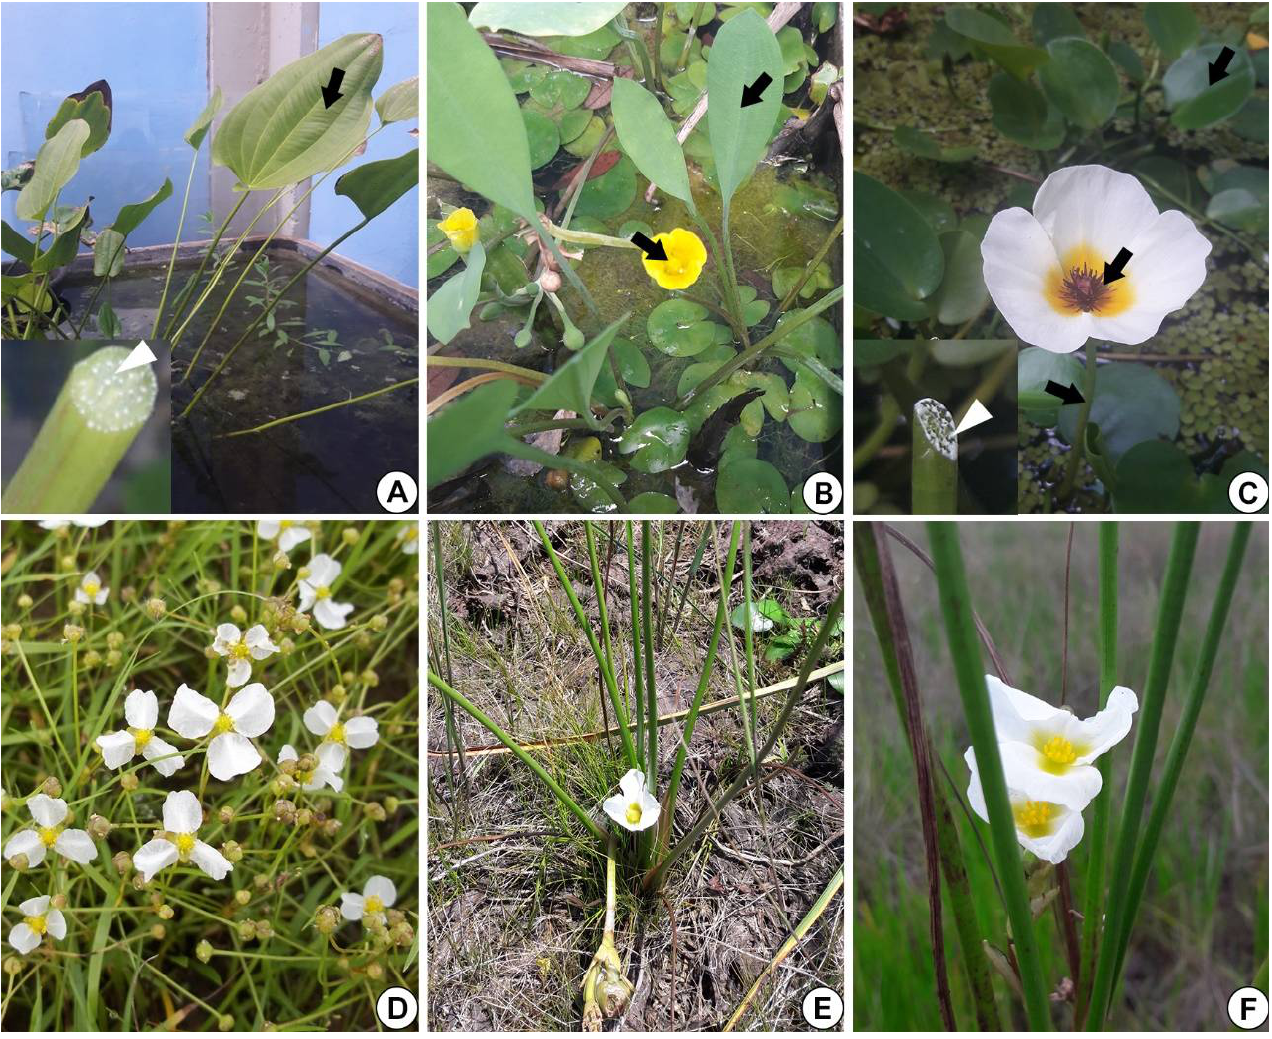
Figure 1. Alismataceae species analyzed. ( A ) Echinodorus grandiflorus leaf (arrow). Inset: detail of the petiole with white secretion (white arrowhead). ( B ) Limnocharis flava showing leaves and flowers (arrows). ( C ) Hydrocleys nymphoides : leaf, petiole and flower (arrows). Inset: note on the left side the petiole with white secretion (white arrowhead). ( D ) Helanthium tenellum (Image D: Giseli Catian). ( E , F ) Sagittaria rhombifolia .